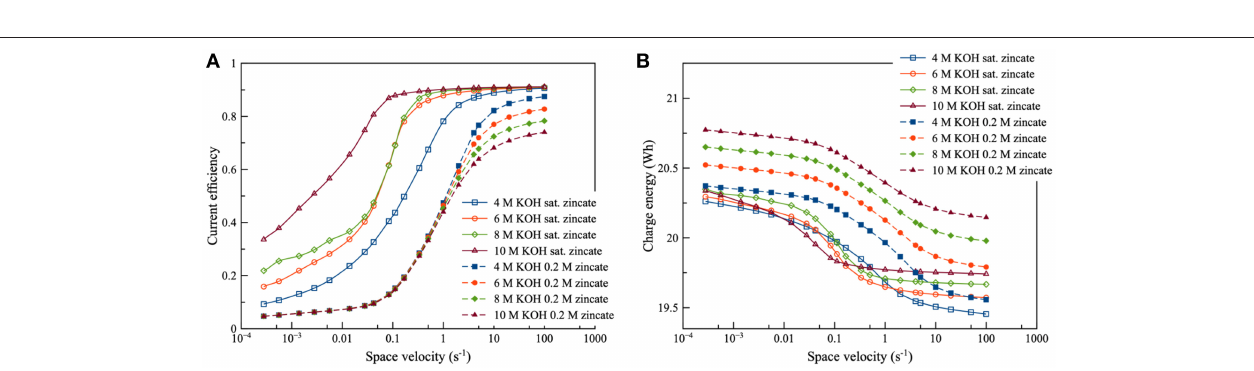
FIGURE 8 | Effects of KOH concentration using different zincate ion initial concentration [0.2M (dotted line) and saturated zincate ion (solid line)] at discharge current density of 100 mA/cm 2 : (A) current efficiency as a function of space velocity and (B) charge energy as a function of space